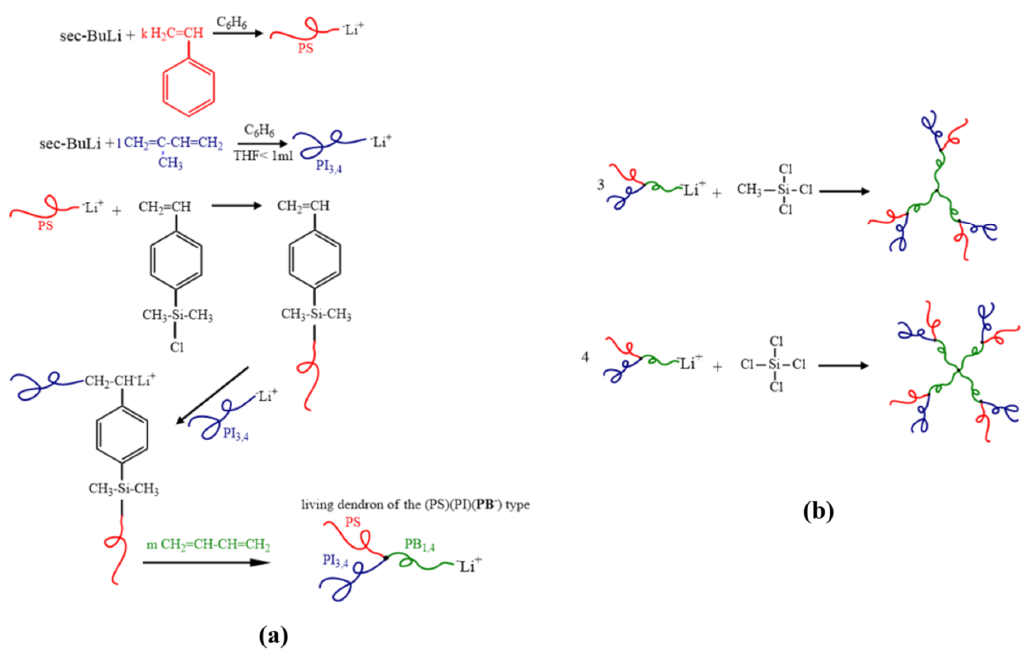
Figure 1. Schematic illustration of: ( a ) the synthetic procedure for the living dendron of the (PS)(PI)( PB − ) type; and ( b ) the coupling reaction for the formation of the final symmetric dendritic terpolymers of the [(PS)(PI)(PB)] 3 or B 3 core and [(PS)(PI)(PB)] 4 or B 4 core respectively.